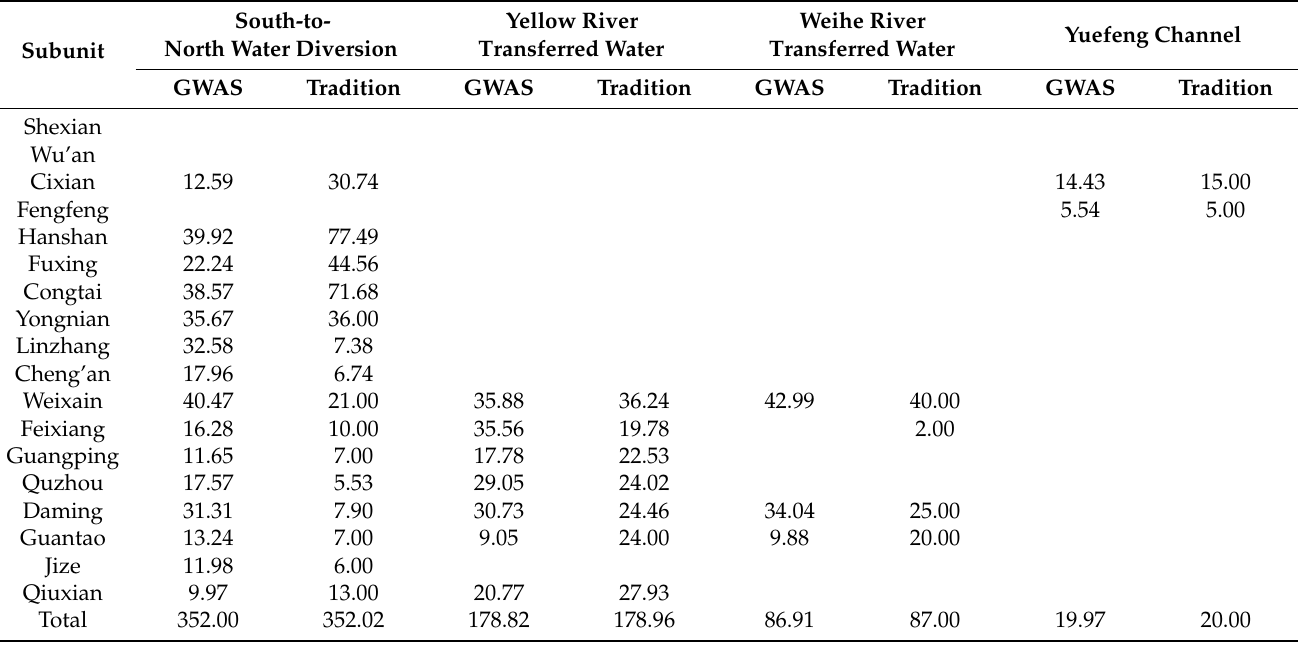
Table 7. Results of reservoir optimal operation in Handan (10 6 m 3